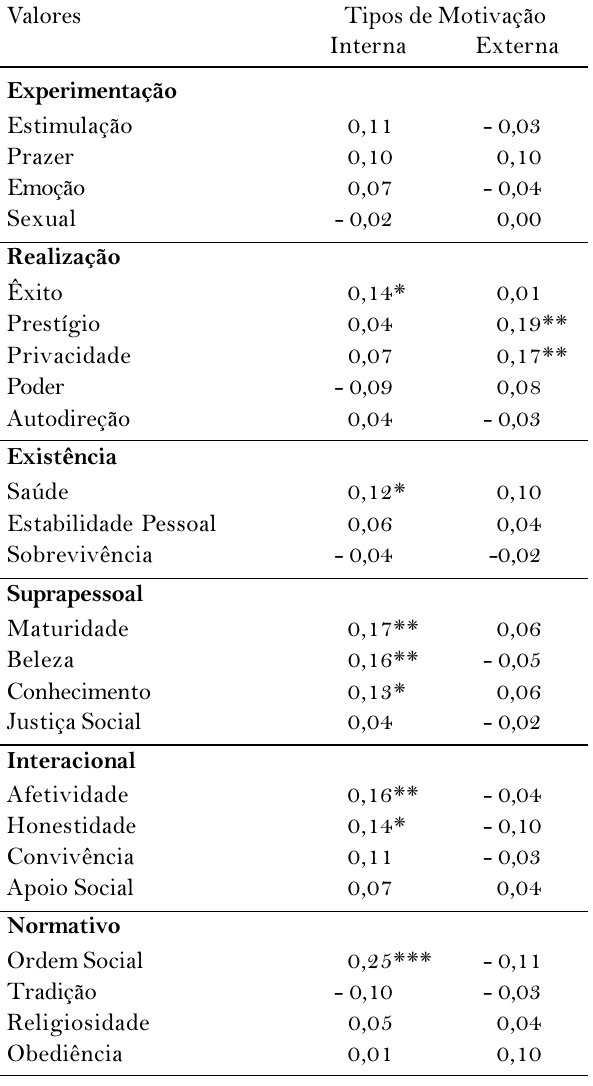
Correlações Parciais entre as Motivações para Responder sem Preconceito (Interna vs. Externa) e os Valores Humanos